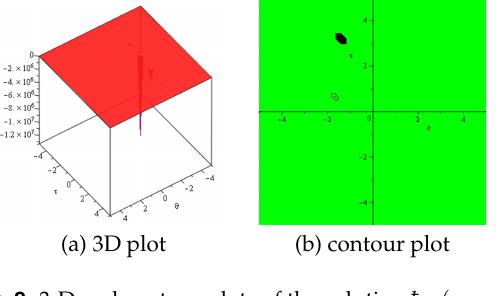
(a) 3D plot (b) contour plot Fig. 2. 3-D and contour plots of the solution ¯ h 35 ( τ , η , ϑ ) with parameters π = 1.5, B = 2.7, p = 0.9, Υ = 4, Θ = 0.5, I = 2, m = 3, η =